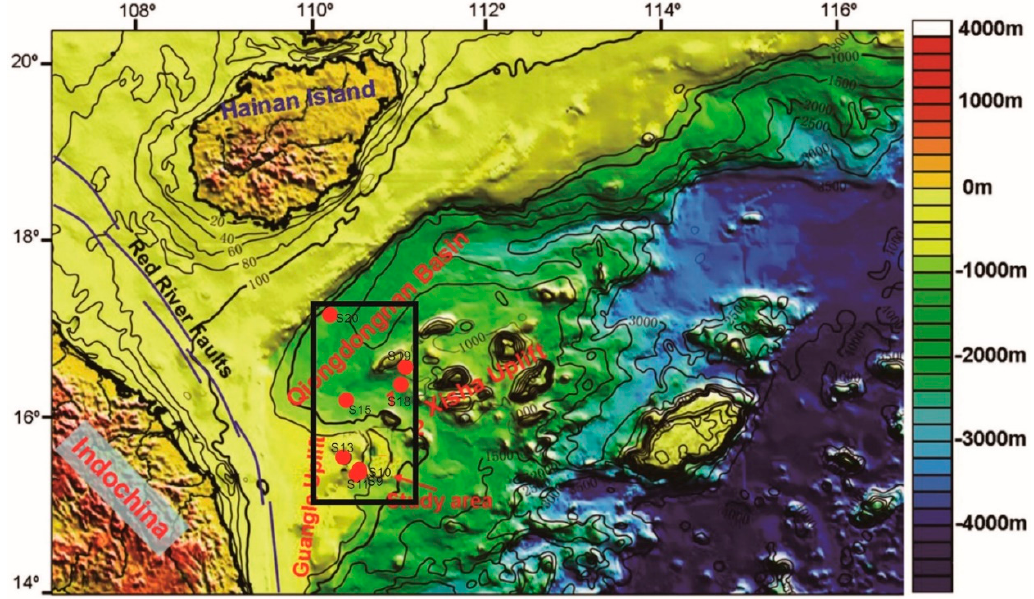
Figure 1. Map of the study area and sampling sites (modified from Sun et al., 2011).